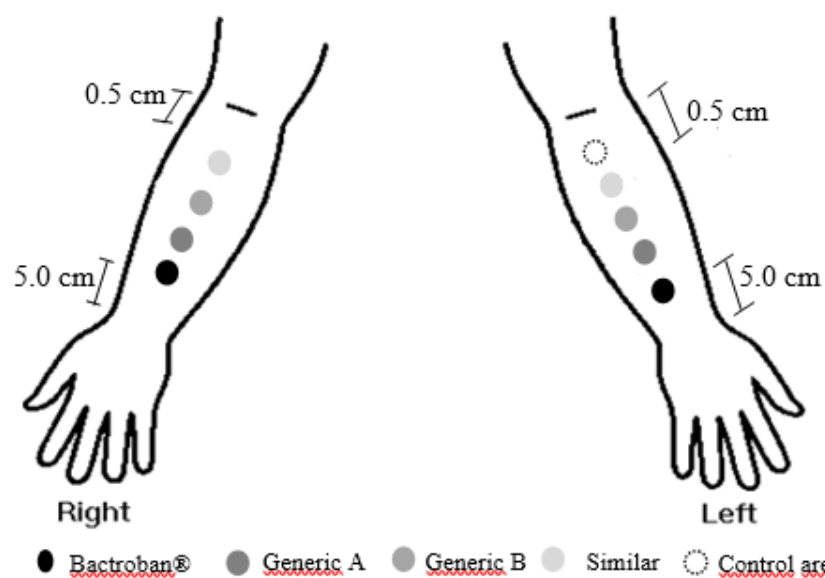
FIGURE 1 - Application sites of the formulations marked on the ventral portion of